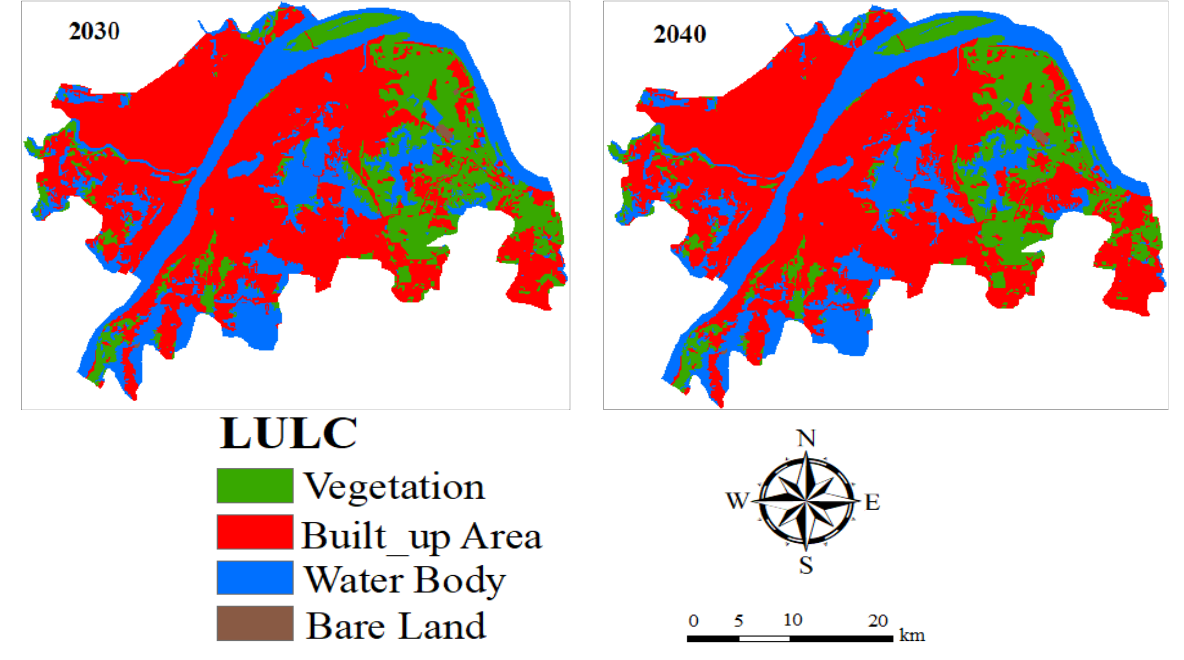
Figure 5. Predicted LULC classes. Table 6. Predicted LULC changes in the study area for 2030 and 2040.